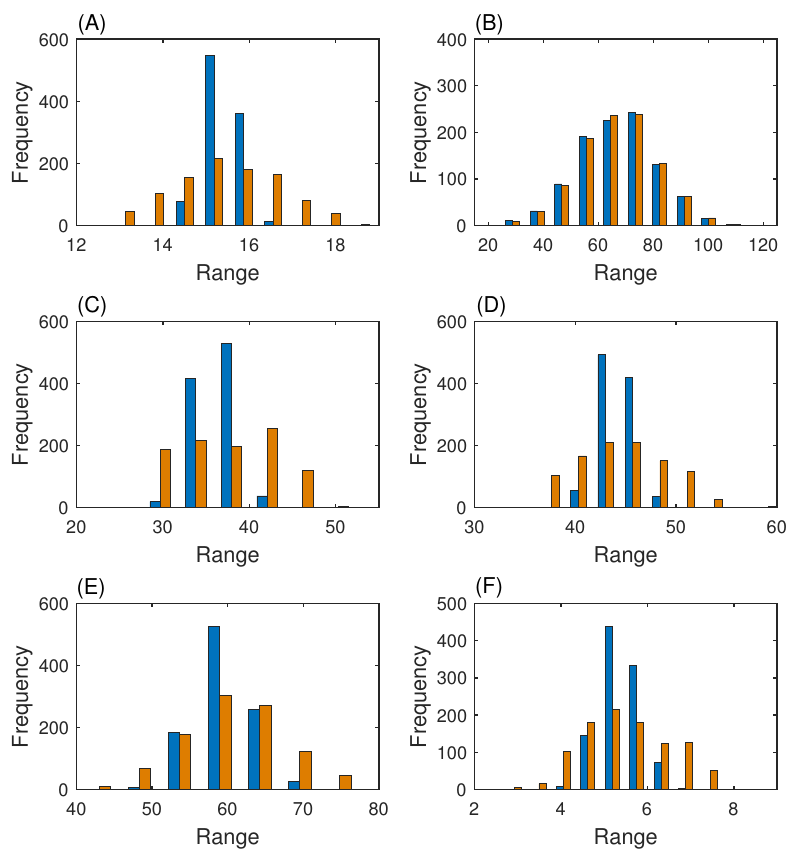
Figure 8. Comparison of the distributions of the estimated parameters and true parameters. ( A ) a 2 . ( B ) a 5 . ( C ) d 2 . ( D ) d 5 . ( E ) k 2 . ( F ) k 5 (blue bar: true parameters; orange bar: estimated parameters).